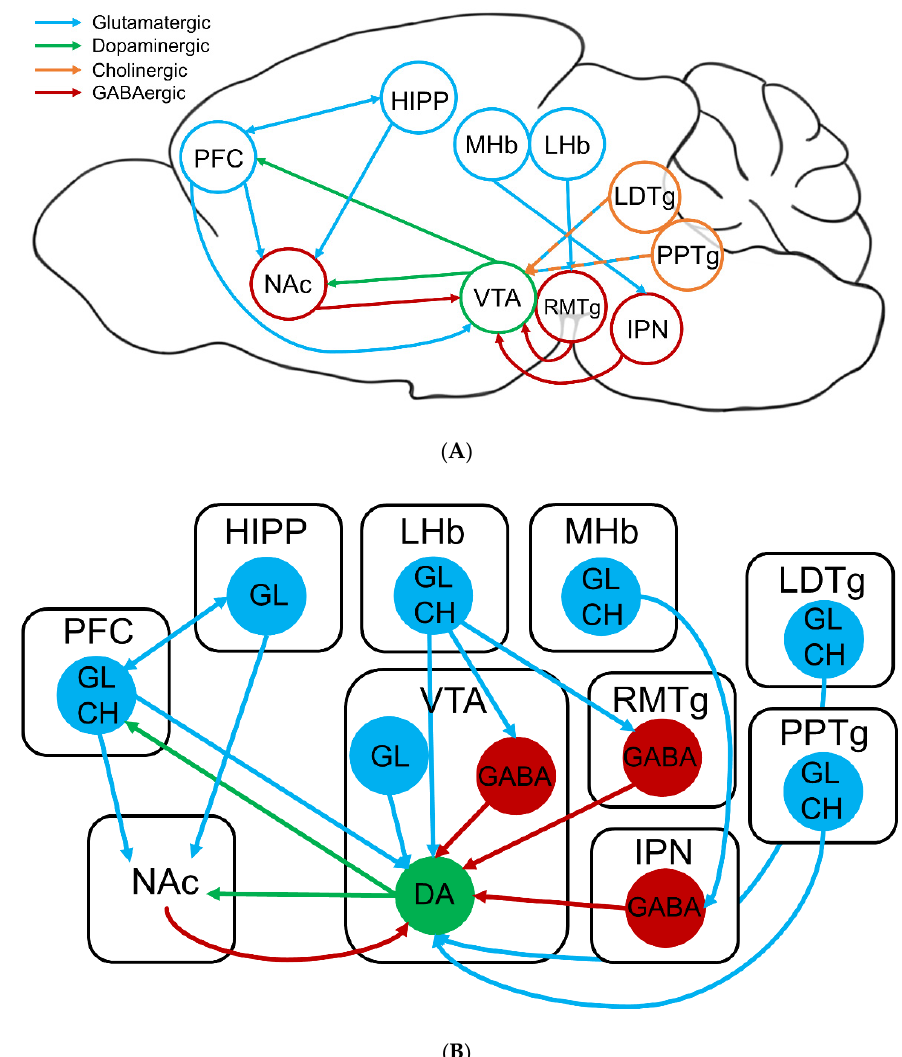
Figure 3. Neurocircuitry involved in nicotine addiction. ( A ) Sagittal mouse brain schematic of the major brain regions and connections involved in nicotine addiction. ( B ) Intricate schematic of the above neurocircuitry. DA: dopaminergic, GABA: GABAergic, GL: glutamatergic, CH: cholinergic neurons. Blue arrows indicate excitatory projections; red arrows indicate inhibitory projections; and green arrows indicate modulatory projections.